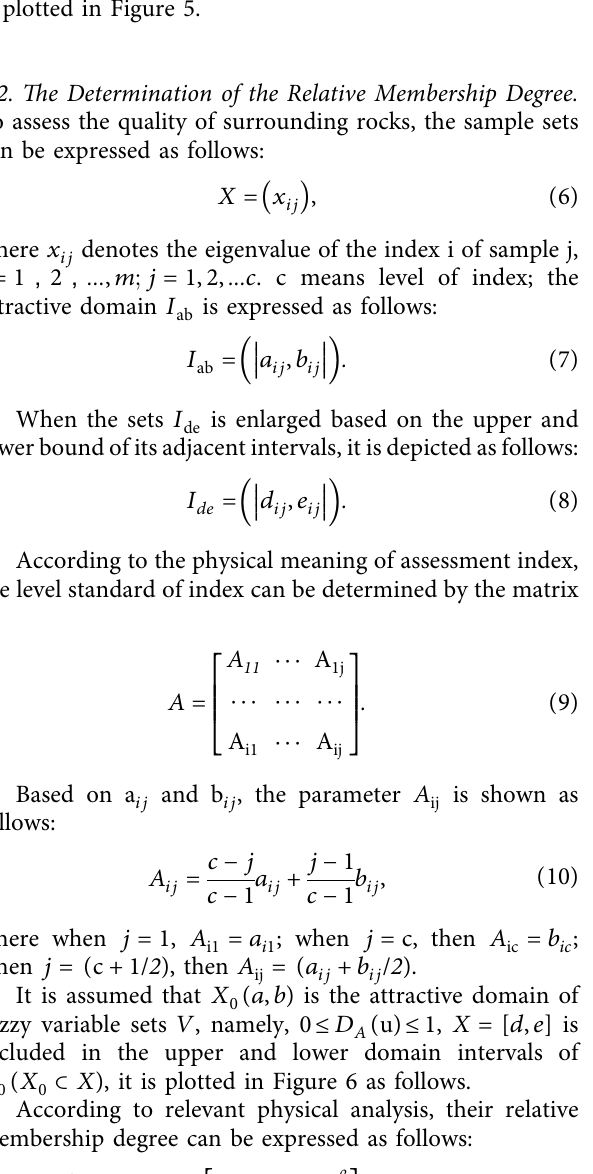
Figure 5: Diagram of the relative difference function.